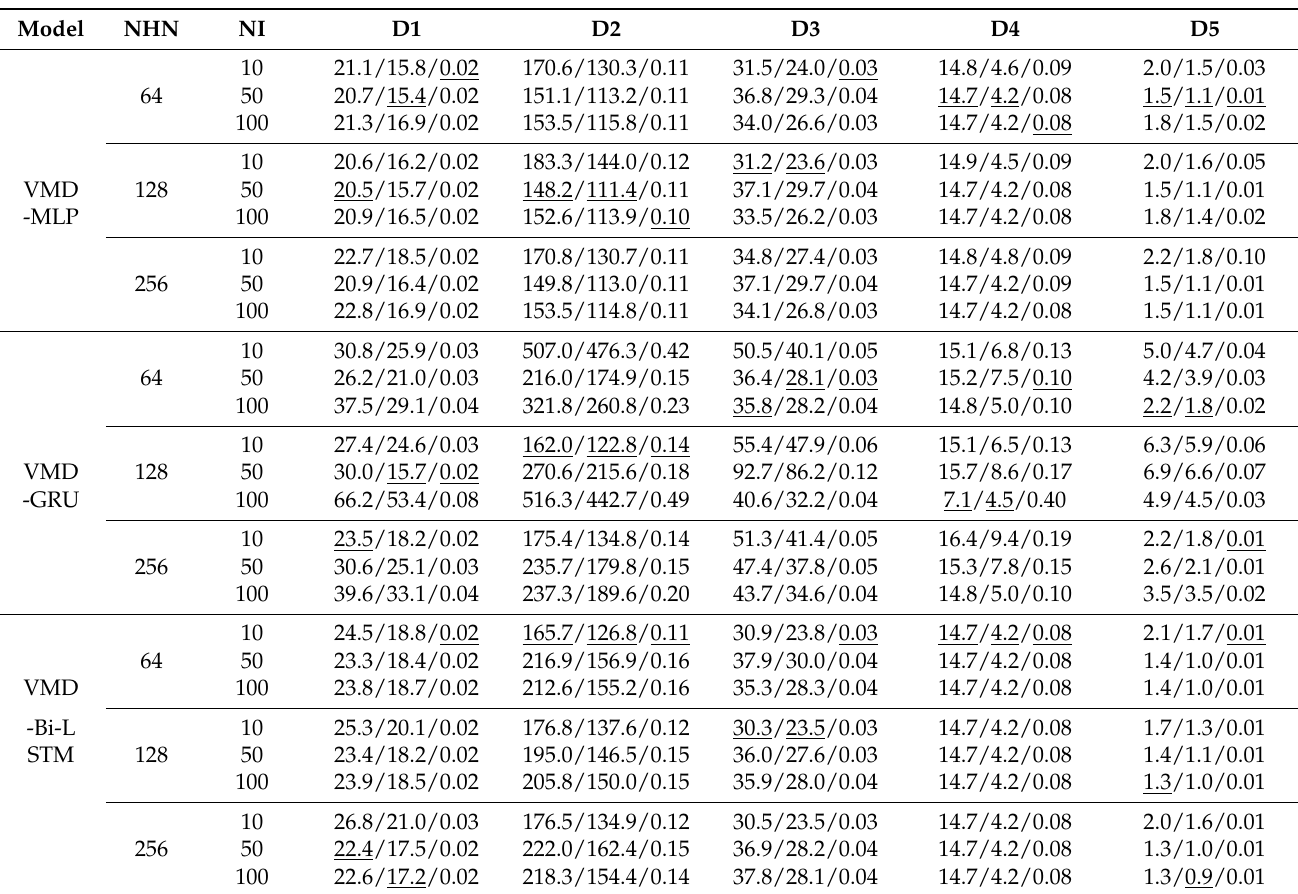
Table 2. Prediction error of 3 h (RMSE/MAE/MAPE).